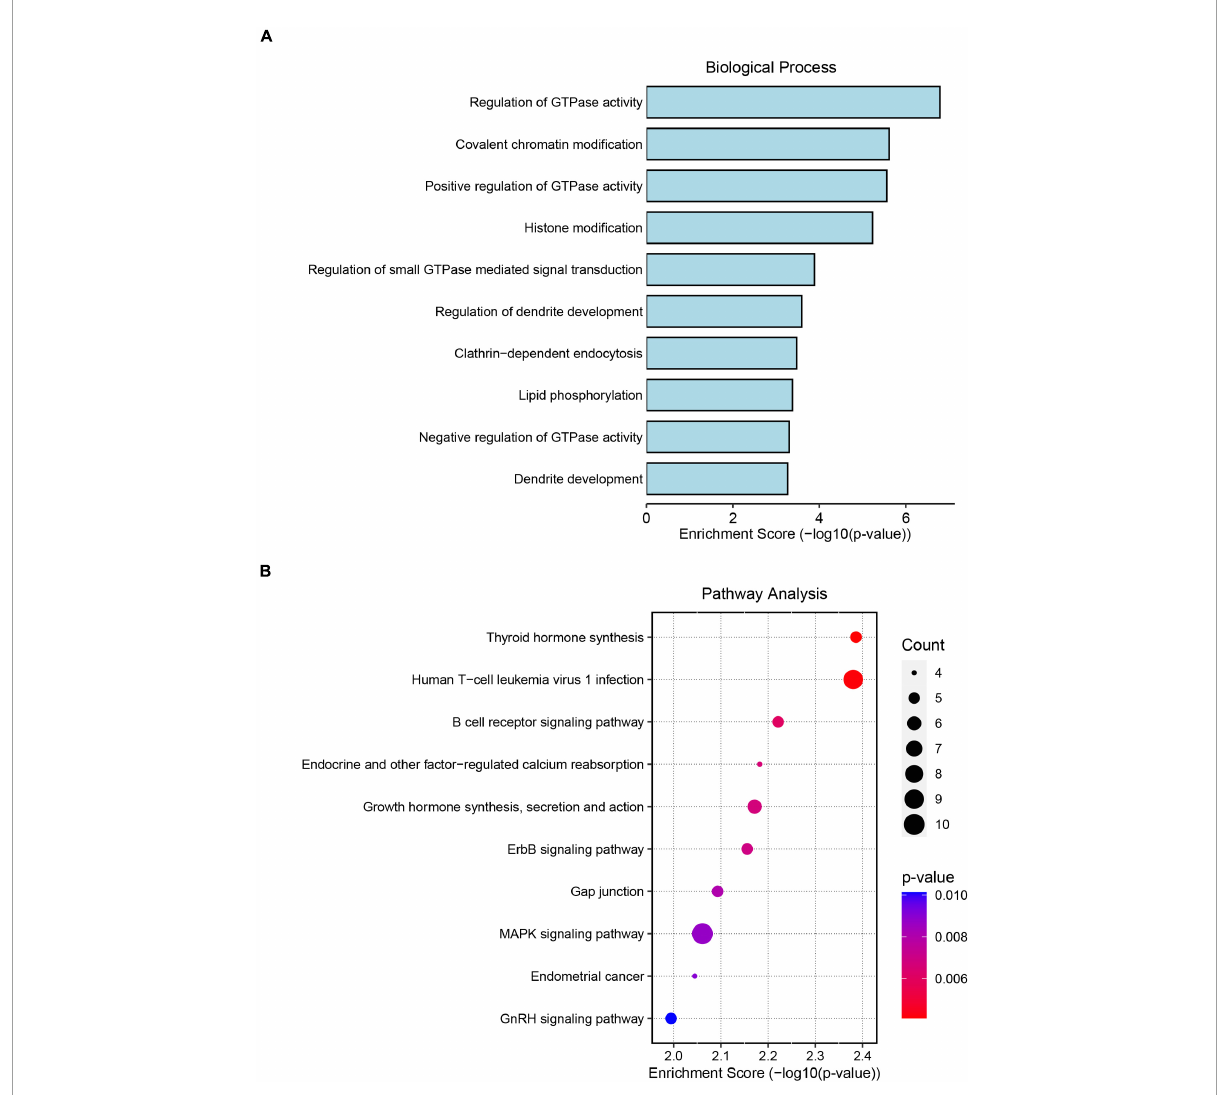
FIGURE2 Gene Ontology (GO) and Kyoto Encyclopedia of Genes and Genomes (KEGG) pathway analyses of significantly altered circRNA host genes. (A) The top 10 biological process terms from GO enrichment analysis of differentially expressed circRNA host genes. (B) The top 10 KEGG pathway analyses of differentially expressed circRNA host